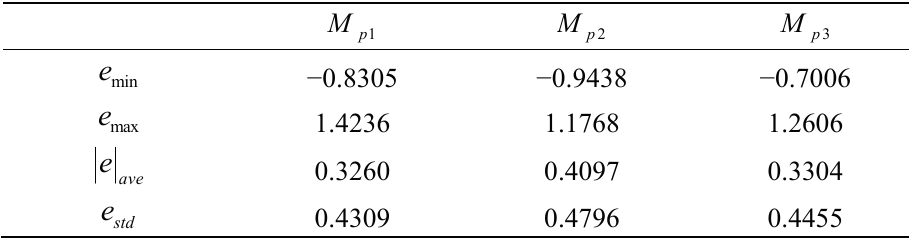
Table 4. Criteria for comparing of three forms of the Oswin